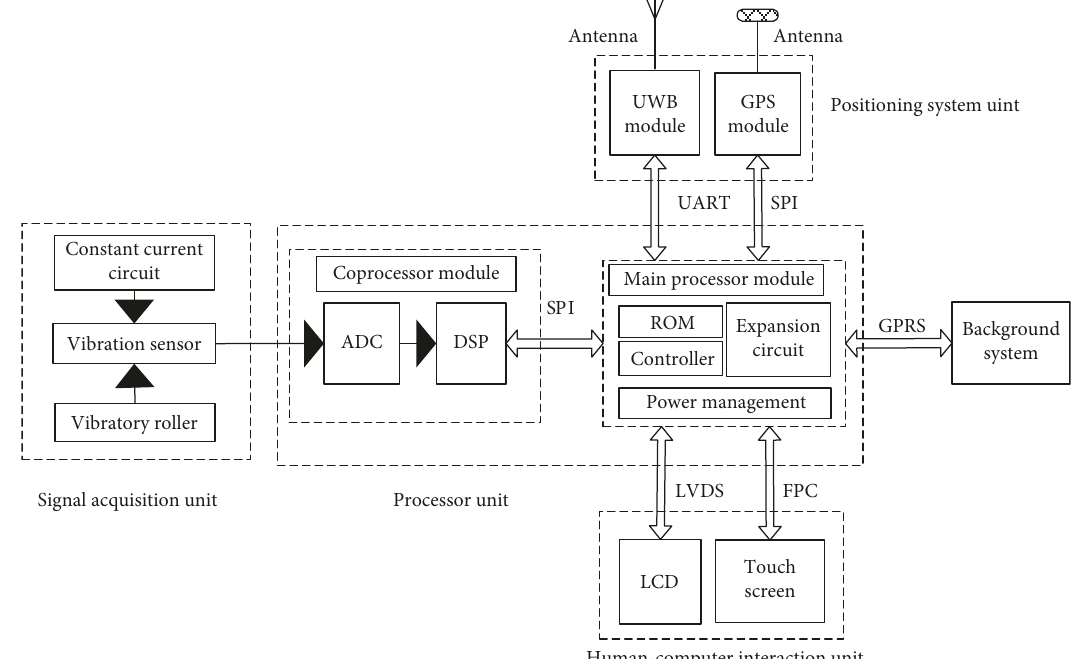
Figure 2: Structure of the compaction detection system. ADC: analog-to-digital converter; DSP: digital signal processing; SPI: serial peripheral interface; UART: universal asynchronous receiver/transmitter; ROM: read-only memory; GPRS: general packet radio service; LVDS: low-voltage differential signaling; FPC: flexible printed circuit; LCD: liquid crystal